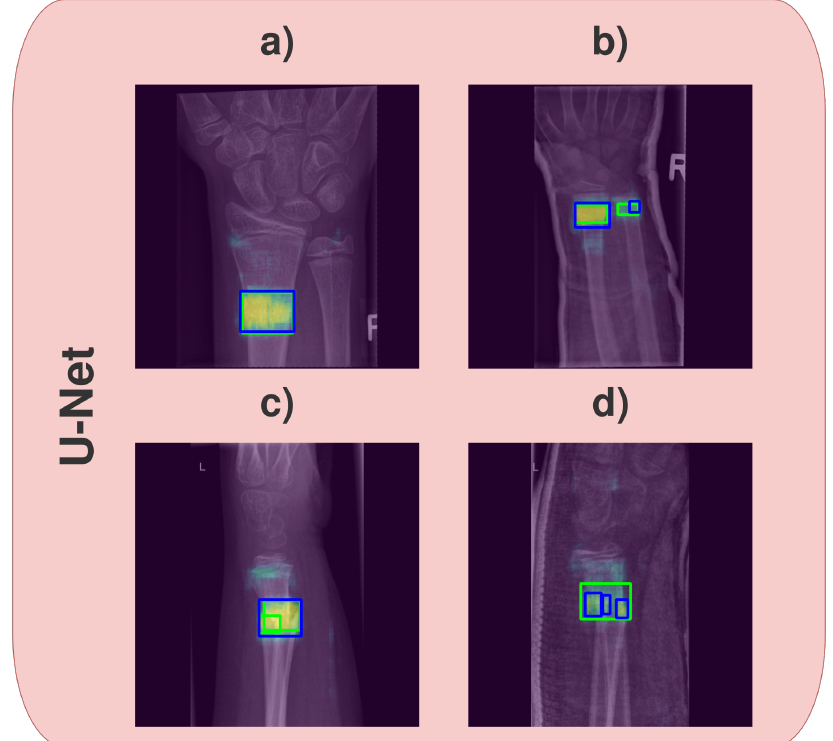
Figure 3. Heat maps generated by the U-Net model, with bounding boxes estimated by the algorithm, shown in blue, and true bounding boxes shown in green. ( a ) Depicts a good prediction by the algorithm, where the estimated bounding box matches the border of the heat map and overlays with the correct bounding box around the fracture. ( b ) Depicts a case having a small intersect-over-union (IoU) score, albeit the heat map fills the whole fracture area. ( c ) Depicts a case where two neighbouring fractures are marked as one fracture by the algorithm. ( d ) Shows the issue where one heat map is split into several bounding